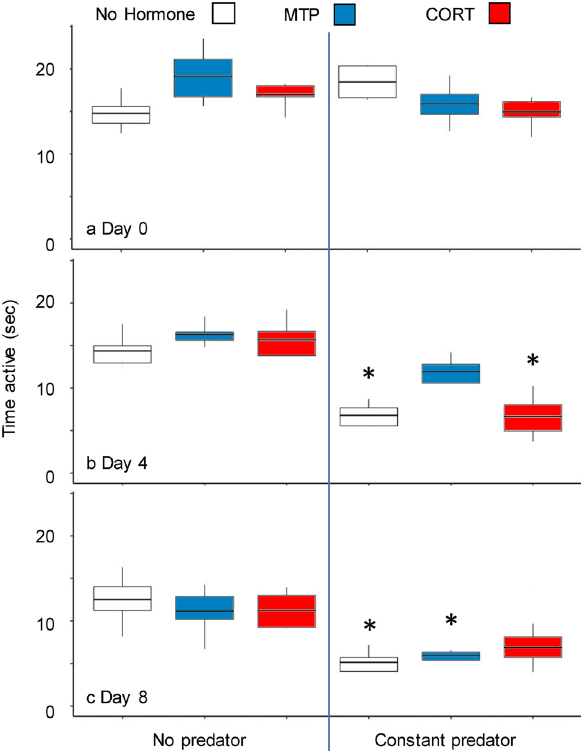
Figure 3. Treatment of wood frog tadpoles with nonlethal exposure to a predator resulted in decreased activity. Shown are boxplots (median and interquartile range) of swimming activity of tadpoles in each treatment combination ( n = 4 replicates) on Day 0 ( a ), Day 4 ( b ), and Day 8 ( c ). Asterisks indicate significant differences compared to the No predator/No hormone treatment (Bonferroni-corrected P < 0.05). Other significant pairwise contrasts are noted in Supplementary Table